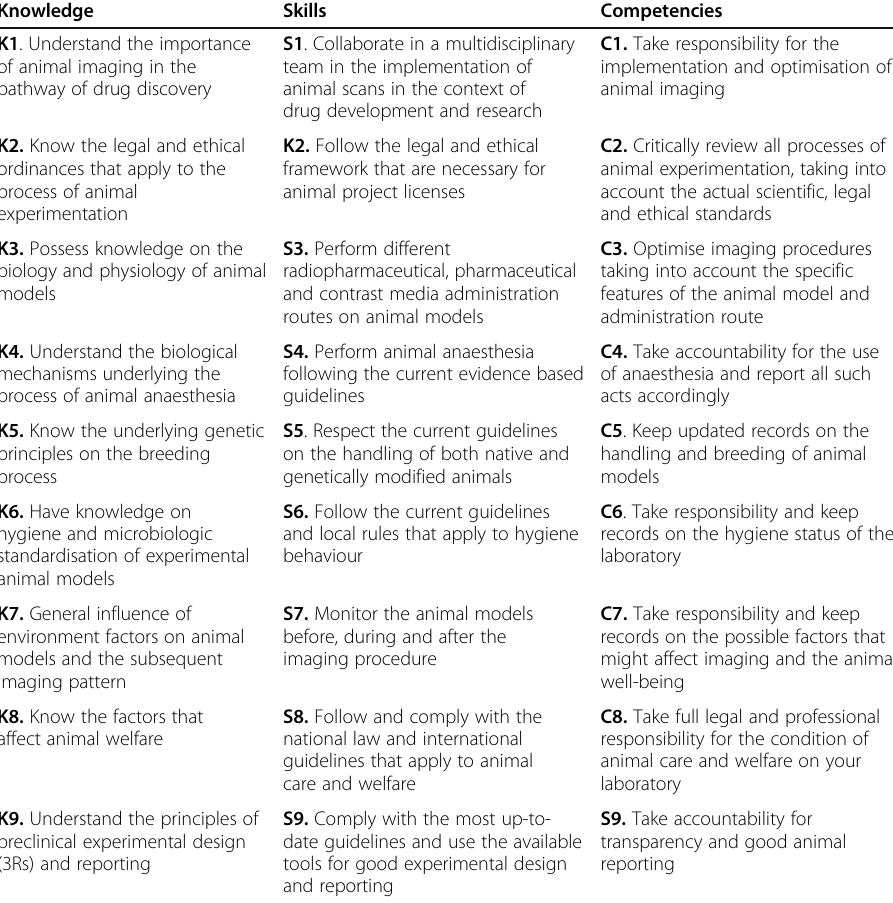
Table 2 Additional set of knowledge, skills and competencies for NMTs and radiographers working in preclinical imaging laboratory